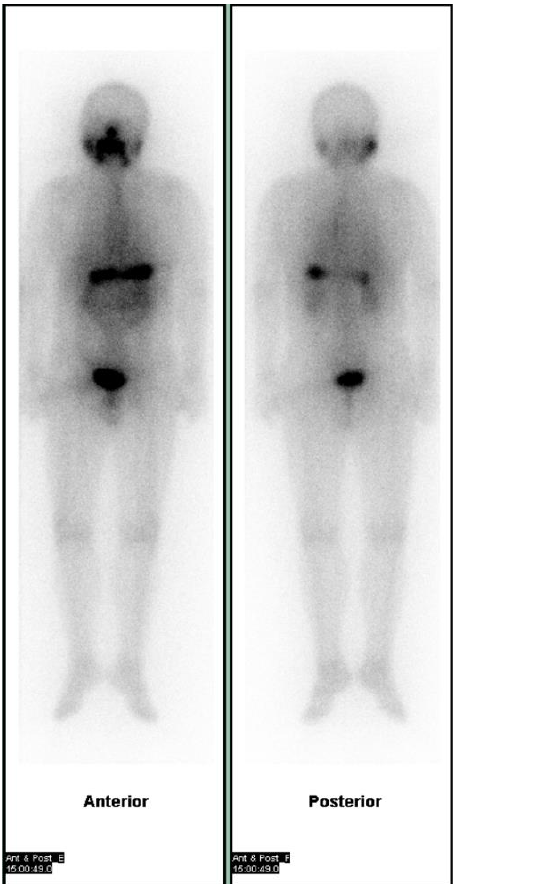
Figure 1. A case with thyroid cancer showing positive I-131 and negative FDG uptake in the lung.